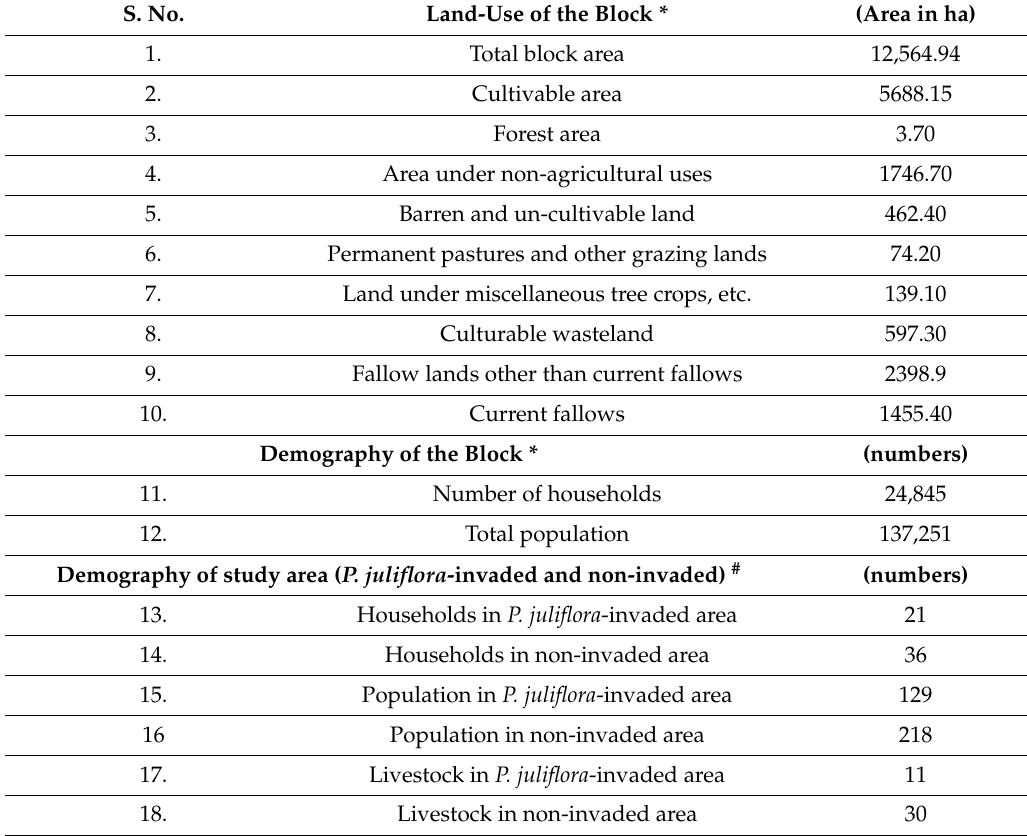
Figure 1. Geographical location of the study area: (a) India, (b) Lucknow, (c) Spatial imagery of the study area (source: Google Earth) (d) experimental field, (e–g) sub-sampling plots. Table 1. General land-use and demographic profile of the study area (Block name: Chinhat, Tehsil name: Lucknow, District: